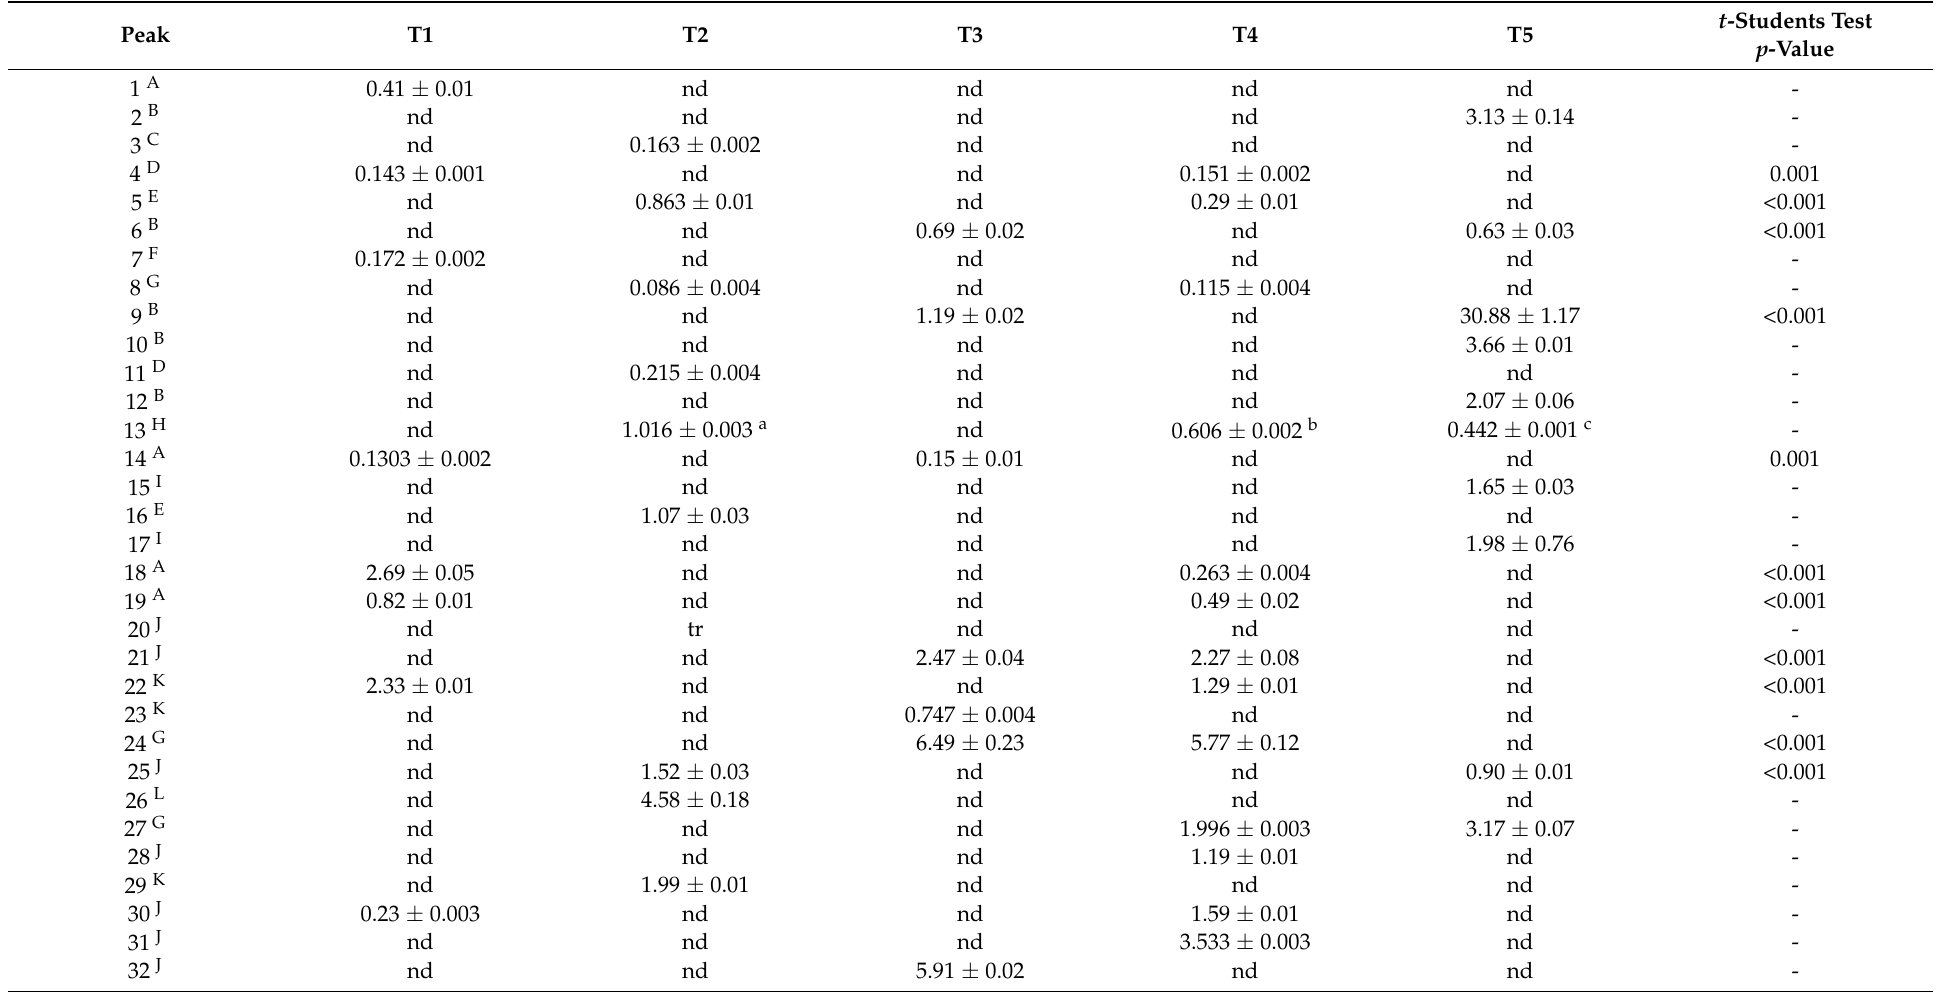
Table 3. Quantification (mg/g of extract) of the phenolic and non-phenolic compounds present in tisanes prepared from five MAP mixtures (mean ± SD).